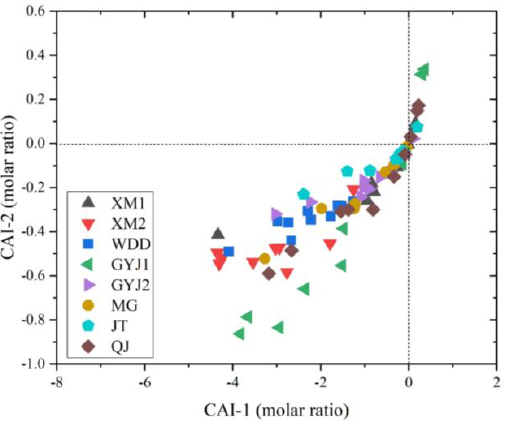
Figure 7. Plots of CAI-1 and CAI-2 of soil − soluble salt from the soil profiles. The soil samples in different depths of soil profiles corresponded to different total data variances. For the surface soil samples, the first factor (PC1) explained 78.06% and 77.18% of the total variance, respectively, for the soils in the WDDR and the BHTR. PC1 was characterized by high concentrations of major ions except for NO 3 − and SO 42 − (Table 3), showing the silicate weathering controls on the soil − soluble phase chemistry in the WDDR. The second factor (PC2) accounted for 21.94% of the total variance and is charac- terized by a high concentration of Na + and Cl − , while low concentrations of other ions (Table 3) imply that precipitation can recharge the surface soils in the WDDR. The PC1 and PC2 are 77.18% and 14.28% for the surface soils in the BHTR (Table 3); high concen- trations of major ions in PC1 and higher Mg 2+ , Cl − , and SO 42 − in PC2 show that much stronger mineral weathering happened in the BHTR. For the soil-soluble salt in 0 – 50 cm soil layers in the WDDR, the PC1 explains 71.36% of the total variance and is characterized by the high concentration of all the total ion concentrations except for NO 3 − while the PC2 is characterized by lower K + and HCO 3 − (Table 3), suggesting a mixed source influenced by mineral weathering and anthropogenic input. The PC1 and PC2 explain 75.47% and 8.7% of the total variance for soil − soluble salt in the BHTR, and the PC2 is characterized by high Na + , Cl − , NO 3 − and SO 42 − , which implies that the ions in soil − soluble salt are also affected by human activities in the BHTR. The rock weathering (e.g., carbonate or/and silicate weathering) is much stronger for soil − soluble salt in the 50 – 100 cm soil layer be- cause the cumulative value is 89.58% and 86.58%, respectively for the soil − soluble salt in the WDDR and BHTR (Table 3). In summary, the potential sources of major ions in soil − soluble salt are precipitation, rock weathering (silicate weathering and carbonate weathering), and anthropogenic input in the water − level fluctuation zone of the lower Jinsha River Basin. Table 3. Physical and chemical parameters on two significant principal components for soil − soluble salt at different depths in the study area. Location